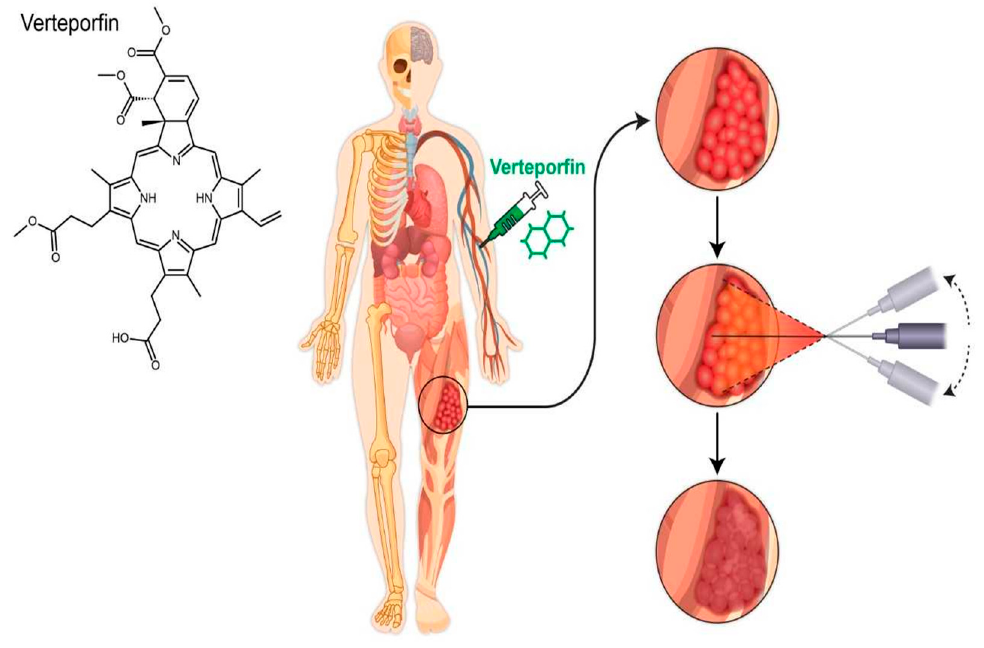
Figure 1. A theoretical demonstration of photodynamic therapy in sarcoma with intravenous verteporfin followed by transcutaneous laser light delivery leading to tumor necrosis.